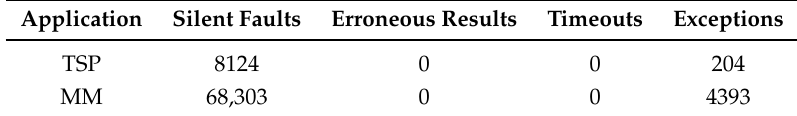
Table 4. Results of fault-injection campaigns on 4MR-8Par applications without a supervisor.